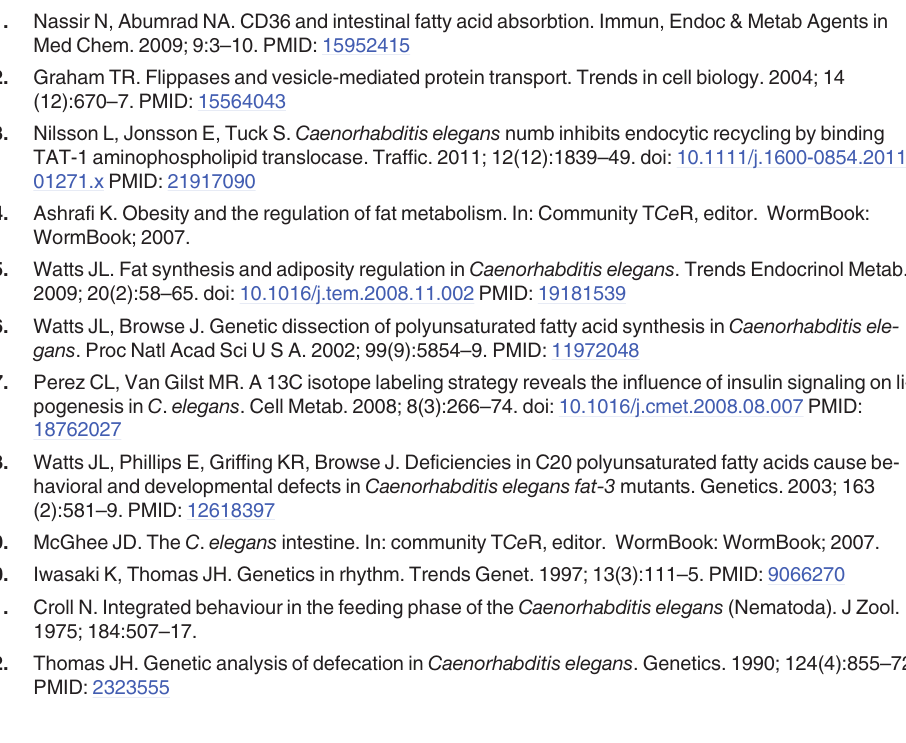
C. Graph showing normalized ratios of total triglycerides to total phospholipids. Error bars de- note 95% confidence intervals. (cid:1) denotes a significant different in the means determined by one-way ANOVA and Fischer's test for least significant difference. (TIF) S5 Fig. Defecation mutants display reduced staining with Nile Red. A. Fluorescence confocal micrographs of young adult hermaphrodite worms fixed with isopropanol and stained with Nile Red. B. Quantification of the Nile Red-stained regions with Imaris software. The regions were imaged and analysed by the methods described in the Materials and Methods section of the main text, and in the legend to S2 Fig. Error bars denote standard errors of the means. (cid:1)(cid:1)(cid:1)(cid:1) denotes significant difference in the means determined by one-way ANOVA and Dun- nett's multiple comparisons test ( σ = 0.05).